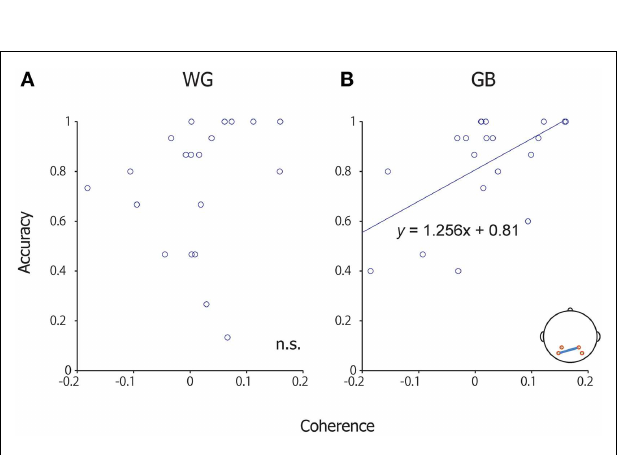
FIGURE 4 | Mean imaginary coherence .The inferior parietal area showed higher MIC under the GB than under theWG condition (GB > WG).